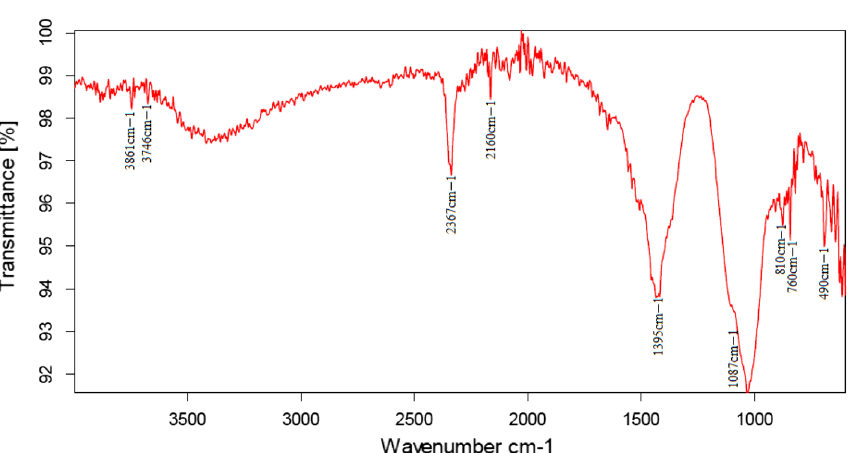
Figure 6. Fourier transform infra-red spectra of zinc oxide nanoparticles biosynthesized by Nigella sativa as reducing agent.